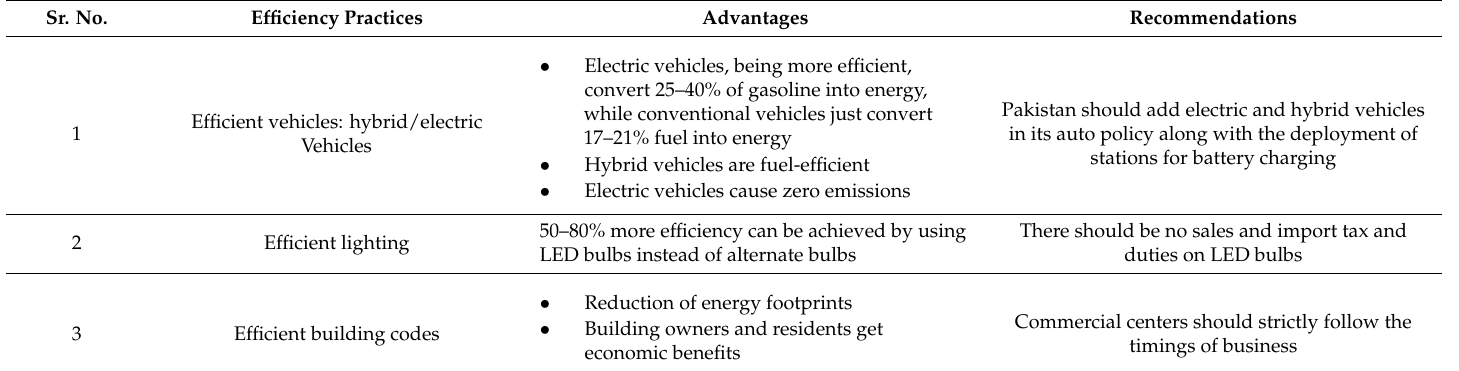
Table 24. Integrated energy policy regarding the conservation and efficiency of energy. Sr. No.